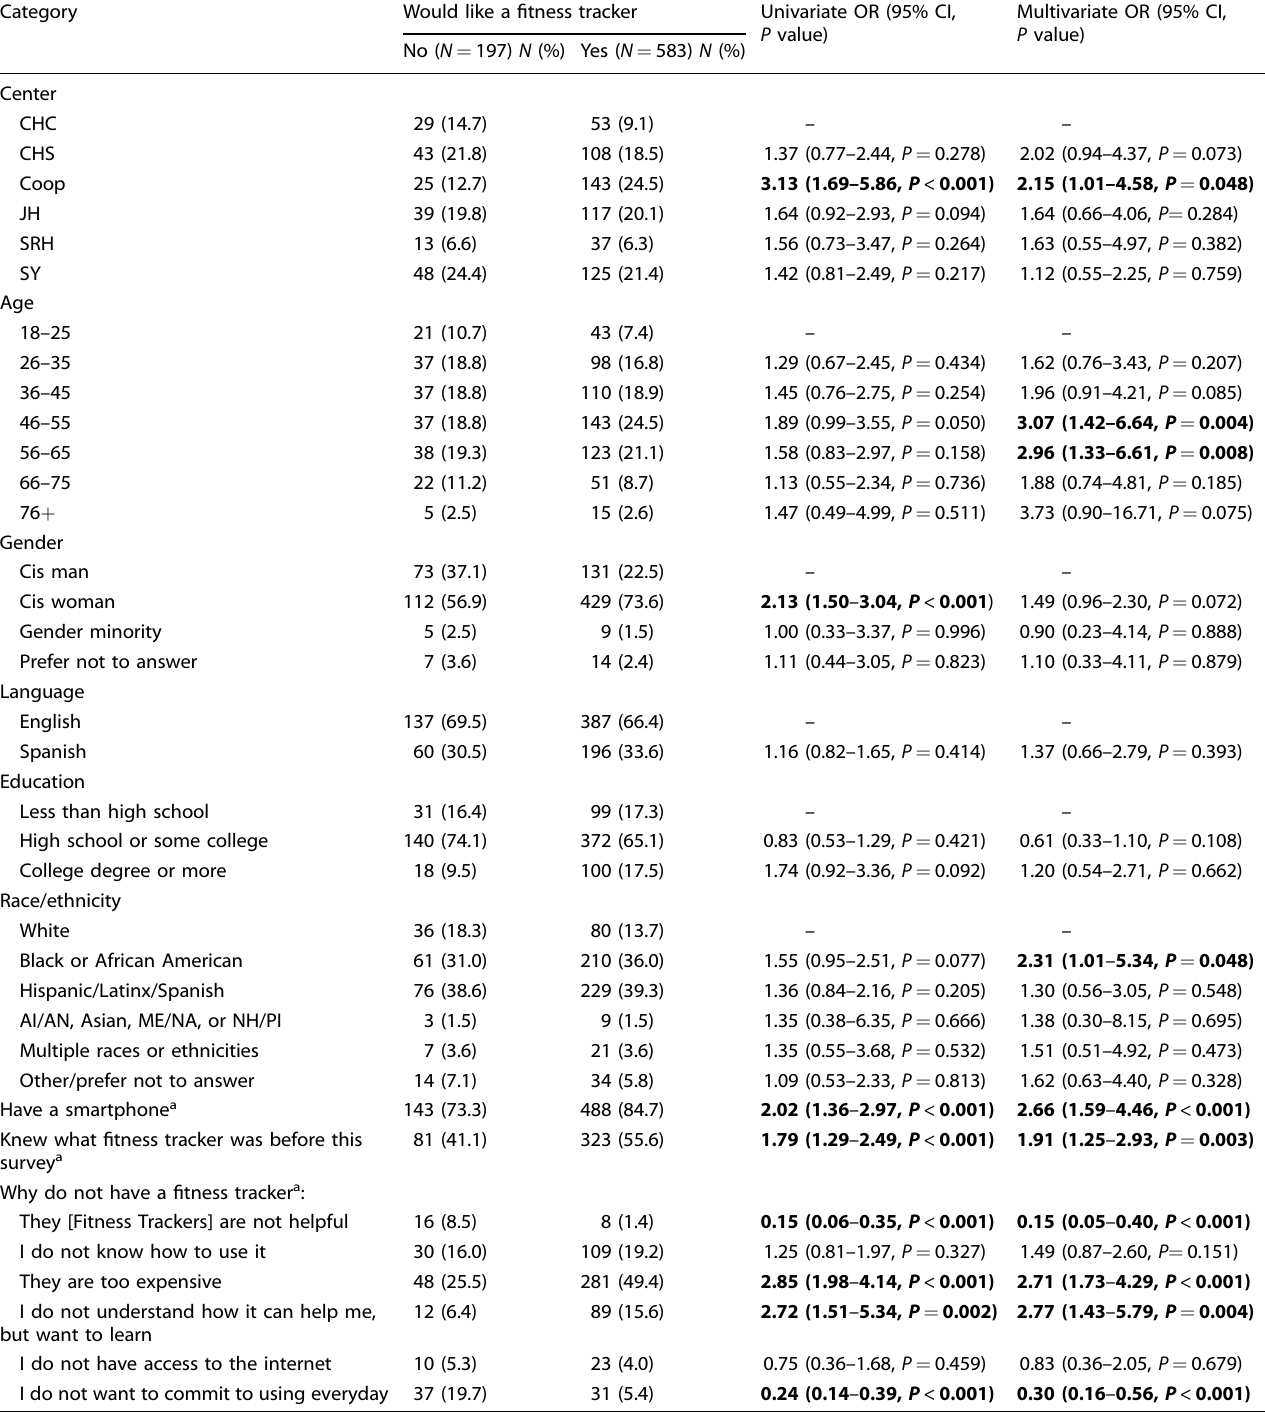
Table 1. Univariate and multivariate logistic regression to identify factors associated with “ Would you like a fi tness tracker? ” .